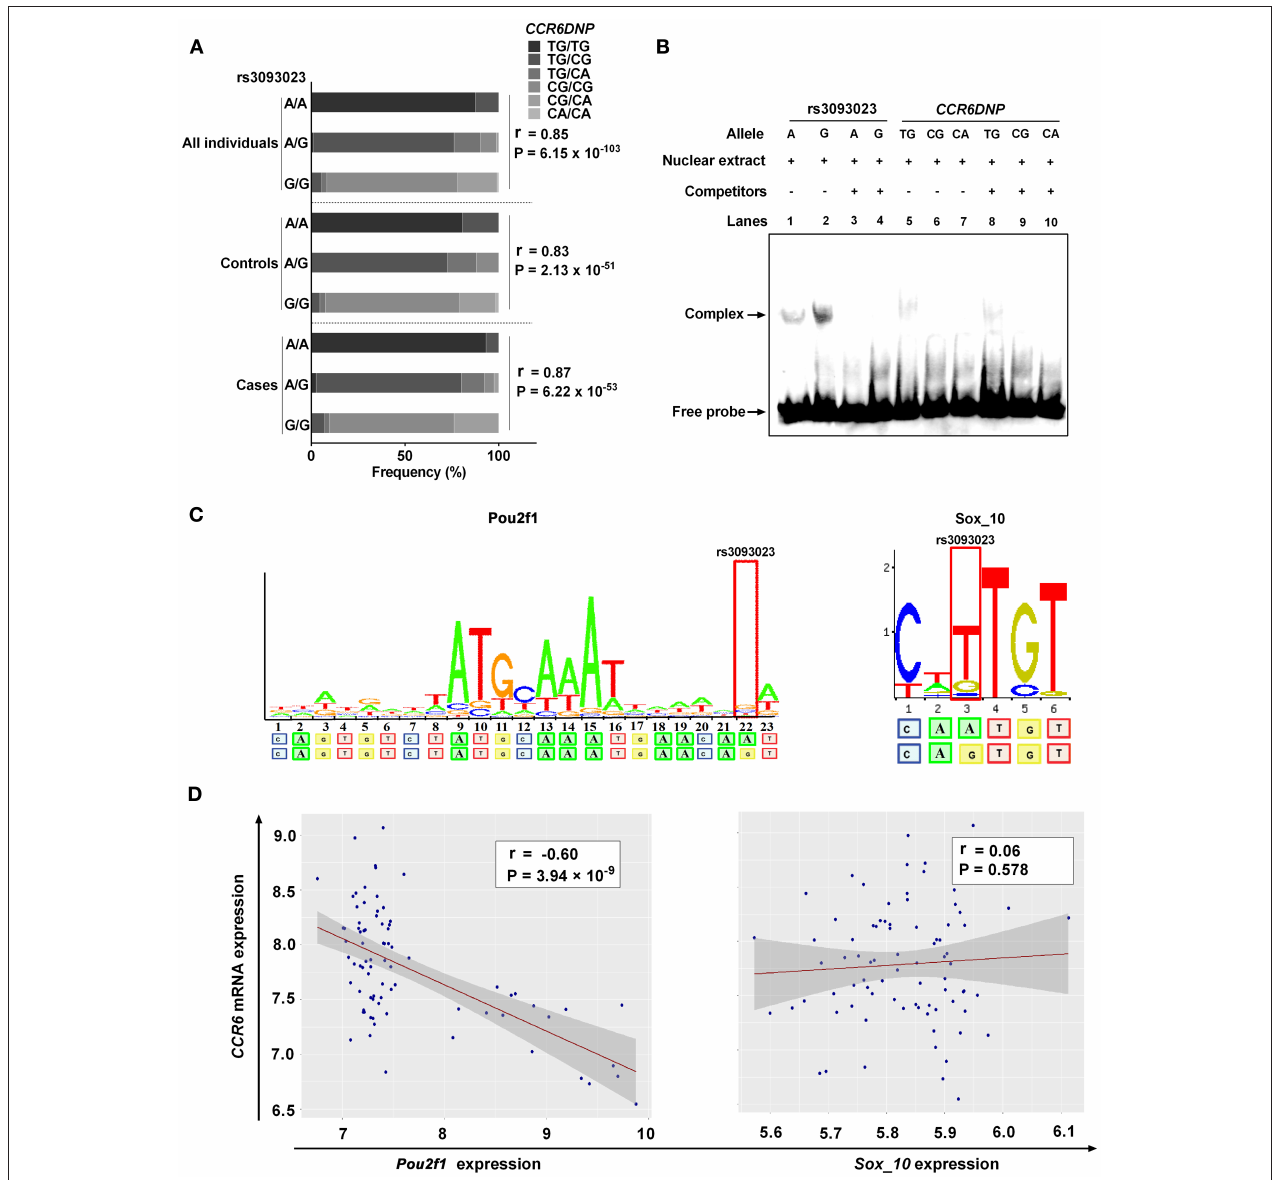
FIGURE 3 | Functional annotation of rs3093023. (A) The association between rs3093023 and CCR6DNP . (B) EMSA. (C) Prediction of transcription factors. (D) Analysis of expression association. EMSA, electrophoretic mobility shift assay.